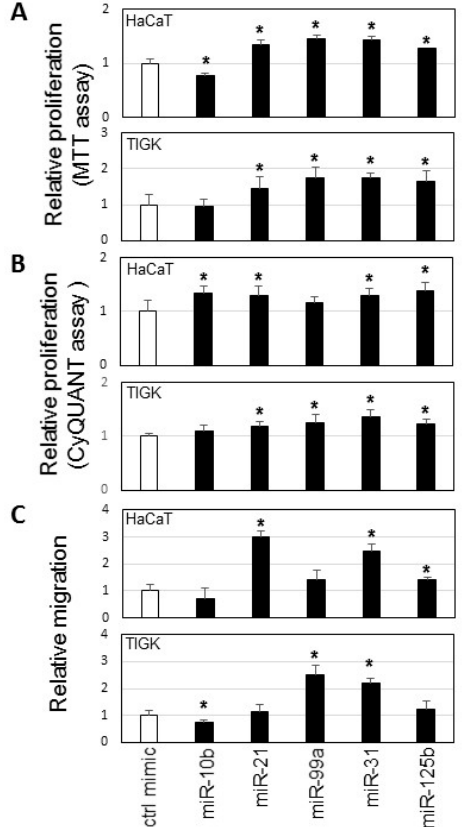
Figure 4. MicroRNA effects on proliferation and cell migration. HaCaT and TIGK cells were transfected with miR-10b mimic, miR-21 mimic, miR-99a mimic, miR-31 mimic, miR-125b mimic, or negative control mimic. MTT assays ( A ), CyQUANT assays ( B ), and cell migration assays ( C ) were performed as described in the Material and Methods section. Data represents at least 3 independent triplicated experiments with similar results (* p < 0.05).